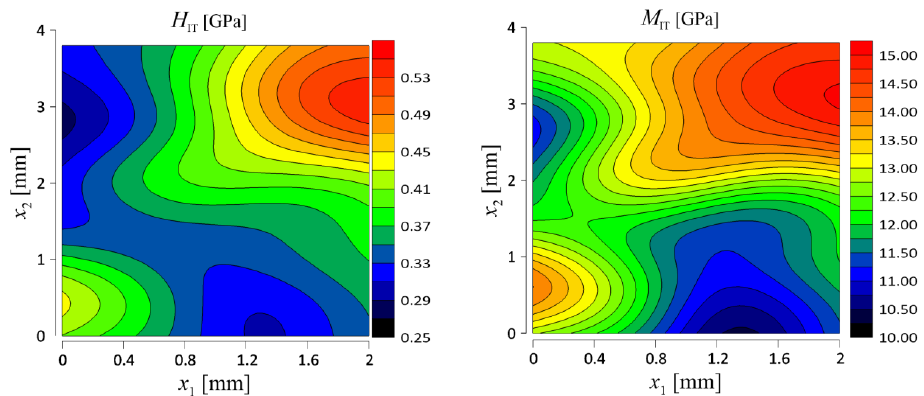
Figure 10. Distribution of hardness and indentation modulus for Board A (reference material).